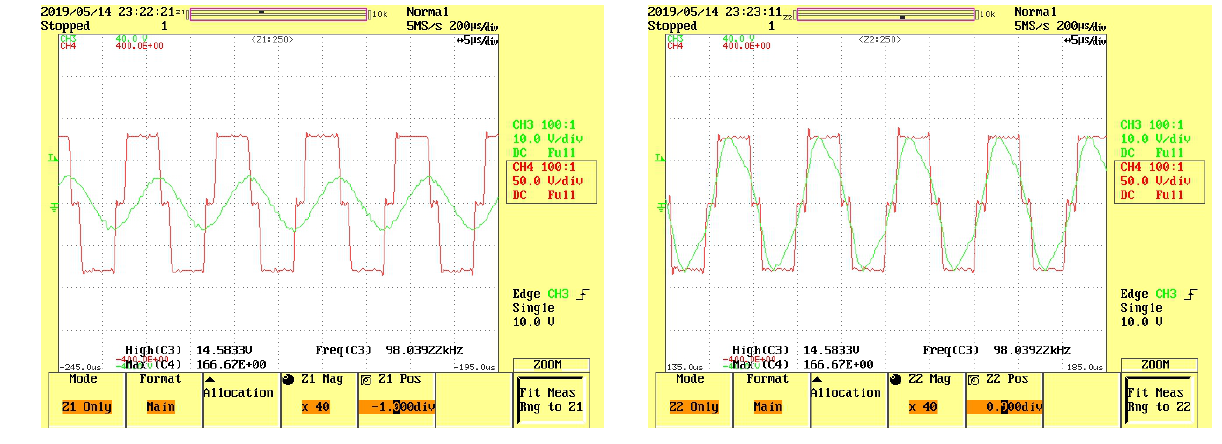
Figure 12. Converter